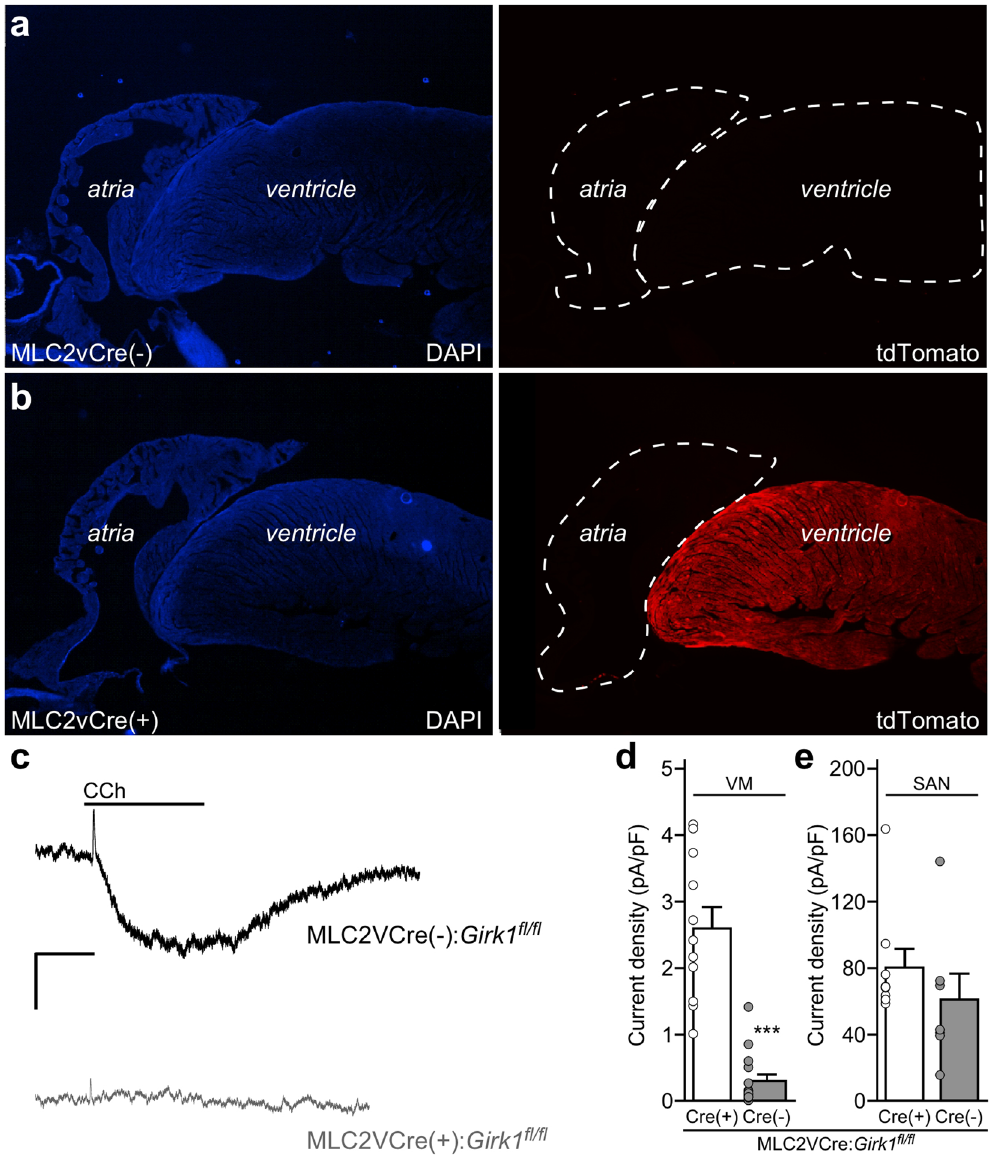
Figure 4. Characterization of mice lacking GIRK channels in the ventricle. ( a , b ) Sections of the heart from MLC2VCre( − ):Ai14-tdTomato and MLC2VCre( + ):Ai14-tdTomato mice, labeled with the nuclear stain DAPI (left panels), showing restricted Cre-dependent gene expression (tdTomato, right panels) in the ventricle of MLC2VCre( + ) mice. ( c ) Whole-cell currents (V hold = − 70 mV) evoked by CCh (100 μ M) in a high-K + bath solution (containing 5 μ M BaCl 2 ) in adult ventricular myocytes from MLC2VCre( − ): Girk1 fl/fl and MLC2VCre( + ): Girk1 fl/fl mice. Scale: 0.2 nA/10 s. ( d ) Summary of CCh-induced current densities in MLC2VCre( − ): Girk1 fl/fl (n = 1 1 cells/2 mice) and MLC2VCre( + ): Girk1 fl/fl (n = 15 cells/2 mice) ventricular myocytes (VM), compared with an unpaired Student’s t-test ( t 24 = 7.5, *** P < 0.001). ( e ) Summary of CCh-induced current densities in adult SAN cells from MLC2VCre( − ): Girk1 fl/fl (n = 9 cells/3 mice) and MLC2VCre( + ): Girk1 fl/fl (n = 7 cells/2 mice) mice, compared with an unpaired Student’s t-test ( t 14 = 1.1, P =